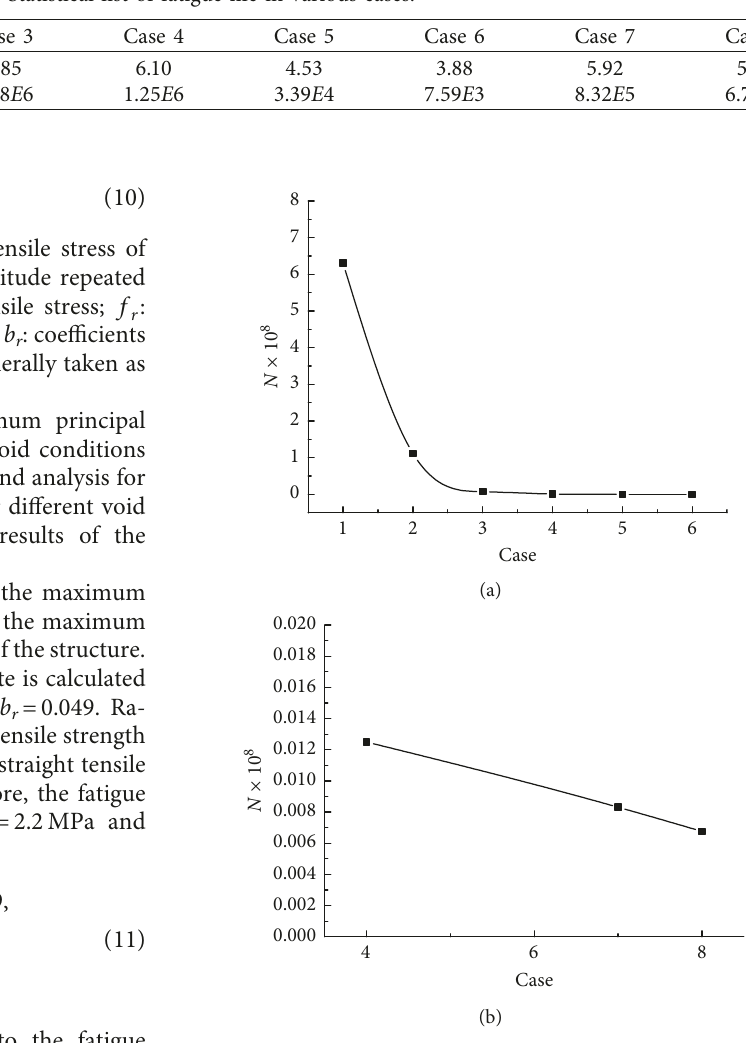
Figure 13: Law curve for structure fatigue life varying with base void